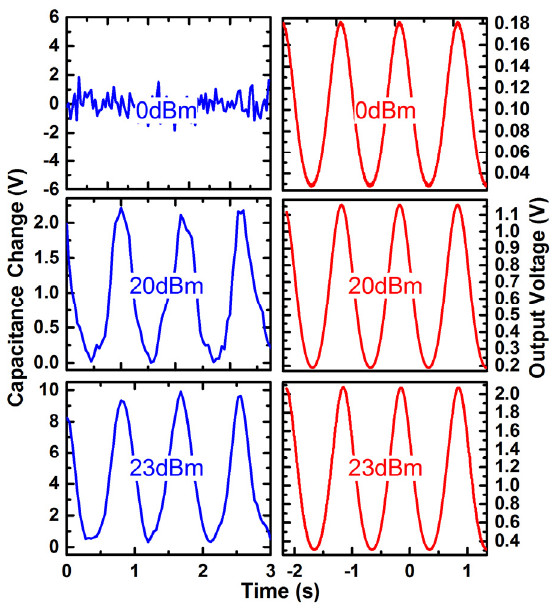
Figure 9. Output response of the MEMS demodulator under low—(0 dBm), medium—(20 dBm) and high ‐ power—(23 dBm) AM signal ( fm = 1 Hz, fc = 10 GHz).